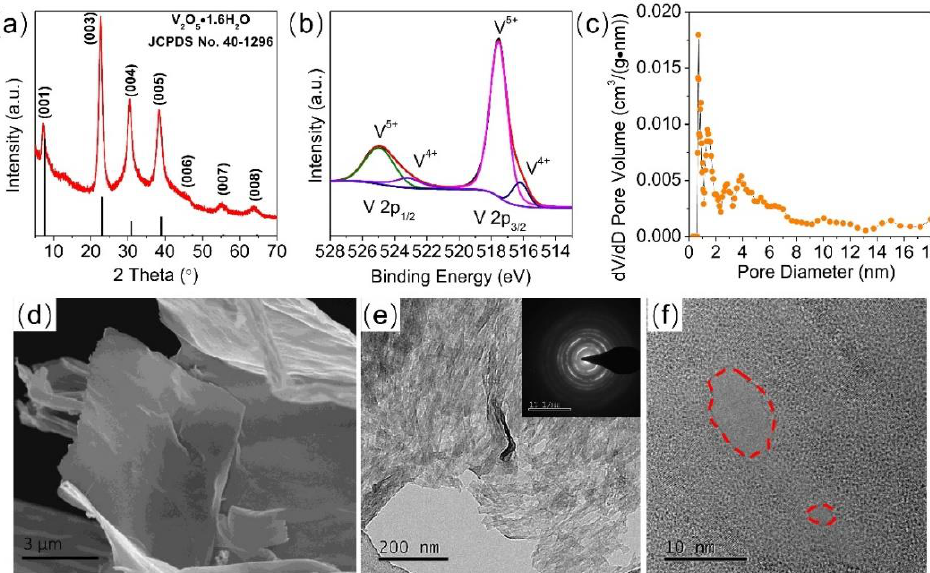
Figure 2. The structural analysis, chemical compositions, and micro-structure characterizations of hydrated V 2 O 5 . ( a ) XRD analysis, ( b ) XPS spectra, ( c ) pore size distribution, ( d ) SEM, ( e ) TEM, and ( f ) high-resolution TEM. Inset: selected area electron diffraction pattern.